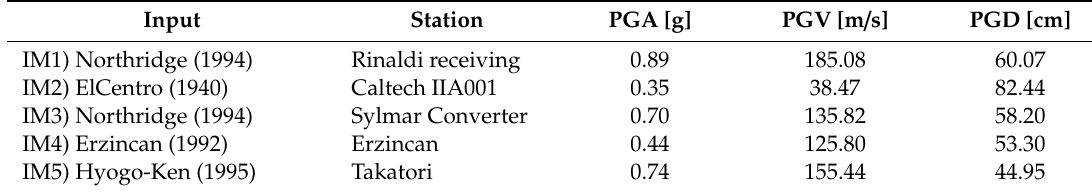
Figure 3. Selected input motions [42]. Table 2. Selected input motions (characteristics).